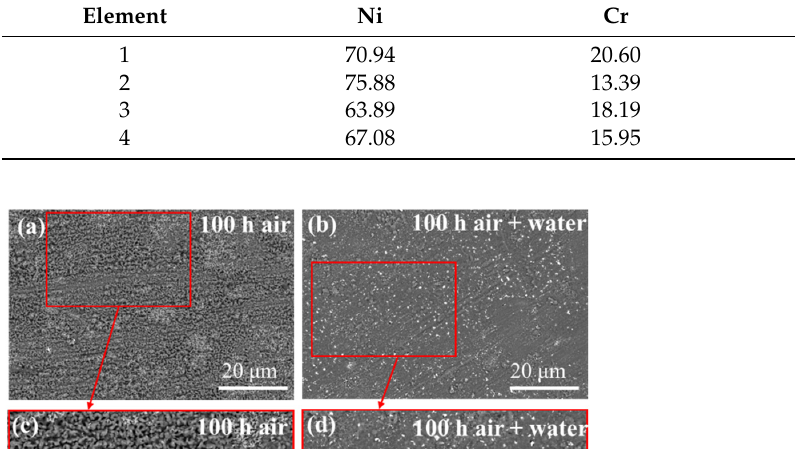
Table 2. The chemical compositions (at.%) of the points in Figure 1 by EDS.